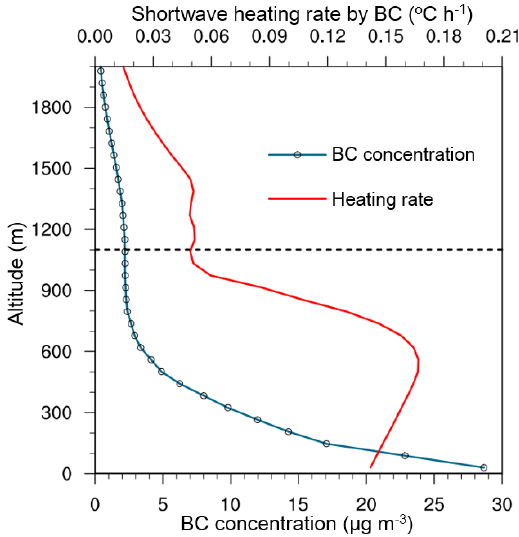
Figure 1. Vertical profiles of BC and shortwave heating rate in- cluded by unit BC mass in the afternoon (12:00–16:00LT) during a heavily polluted episode on 23–24 December 2013 in Beijing. The black dashed line denotes the average PBL height during the same daytime period. The BC profile was extracted from regional WRF- Chem modeling by Ding et al.